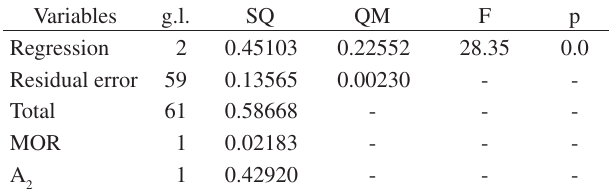
Figure 2. Graph of the residues as a function of adjusted values.